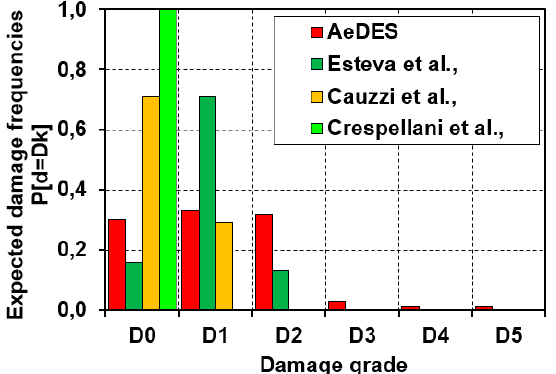
Figure 16. Comparison among damage frequencies in the inspected area between the used attenuation models and the AeDES forms.